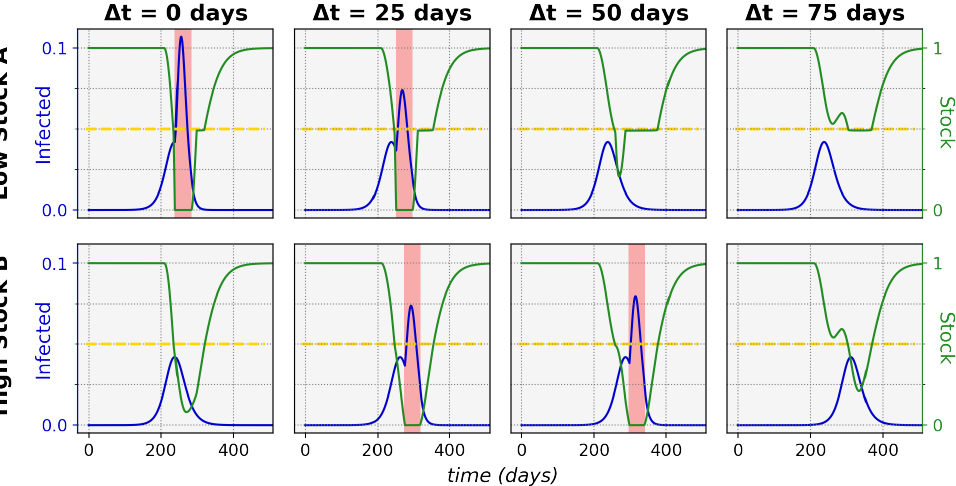
Figure 5. Effect of increasing epidemic onset time difference on sharing success of unequal com- munities. Indicated are the proportions of infected (blue) relative to the total community population and the proportions of stock (green) relative to the maximum stock over time. Critical zero-stock periods are shaded in red and the sharing threshold ( θ = 0.5) is indicated by the yellow dotted = 1 × 10 7 and S max = 7 × 10 7 . By line. The communities had unequal maximum stocks, with S max B A increasing the epidemic onset time difference, the system transitions from only high-stock community B weathering the epidemic with low infected ratios (for ∆ t = 0 days), via both communities reaching high infected ratios (for ∆ t = 25 days) and only low-stock community A reaching a low infected ratio (for ∆ t = 50 days), to both having low infected ratios (for ∆ t = 75 days). This behavior is observed for the specific settings, as indicated by the pink dashed line in Figure 4, but more generally illustrates the impact of epidemic onset time difference on the possible system outcomes. n = 1.7 × 10 7 , R 0 = 2.3, γ = 1/6, r = 0.4, w = 4, P ( 0 ) = 5 × 10 7 , P max = 4 × P ( 0 ) , D ( 0 ) = P ( 0 )